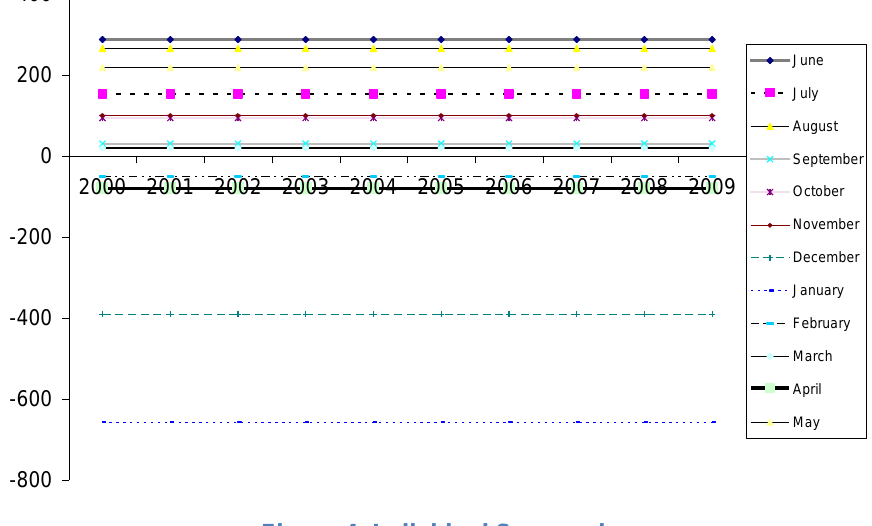
Figure 4 Individual